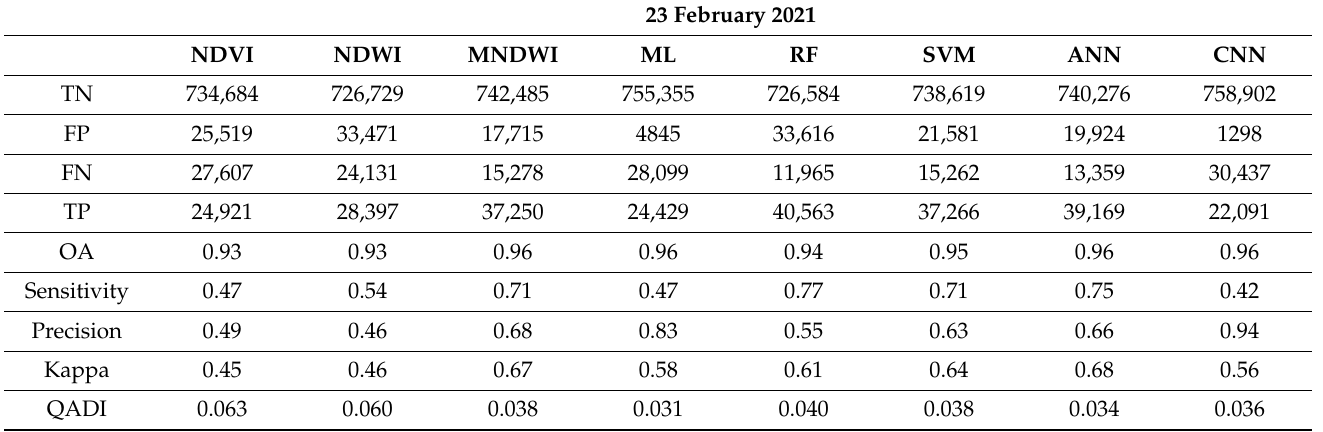
Table 2. Statistical comparison of methods for the second date.